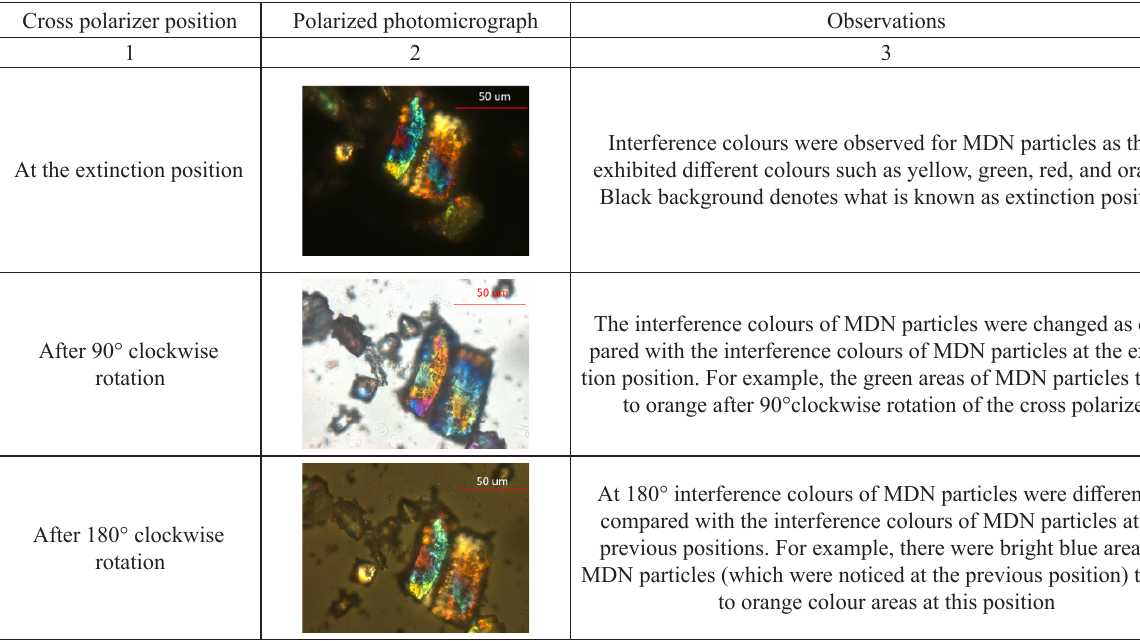
Photomicrographs of MDN particles at the extinction position and after clockwise rotation of the cross polarizer at different